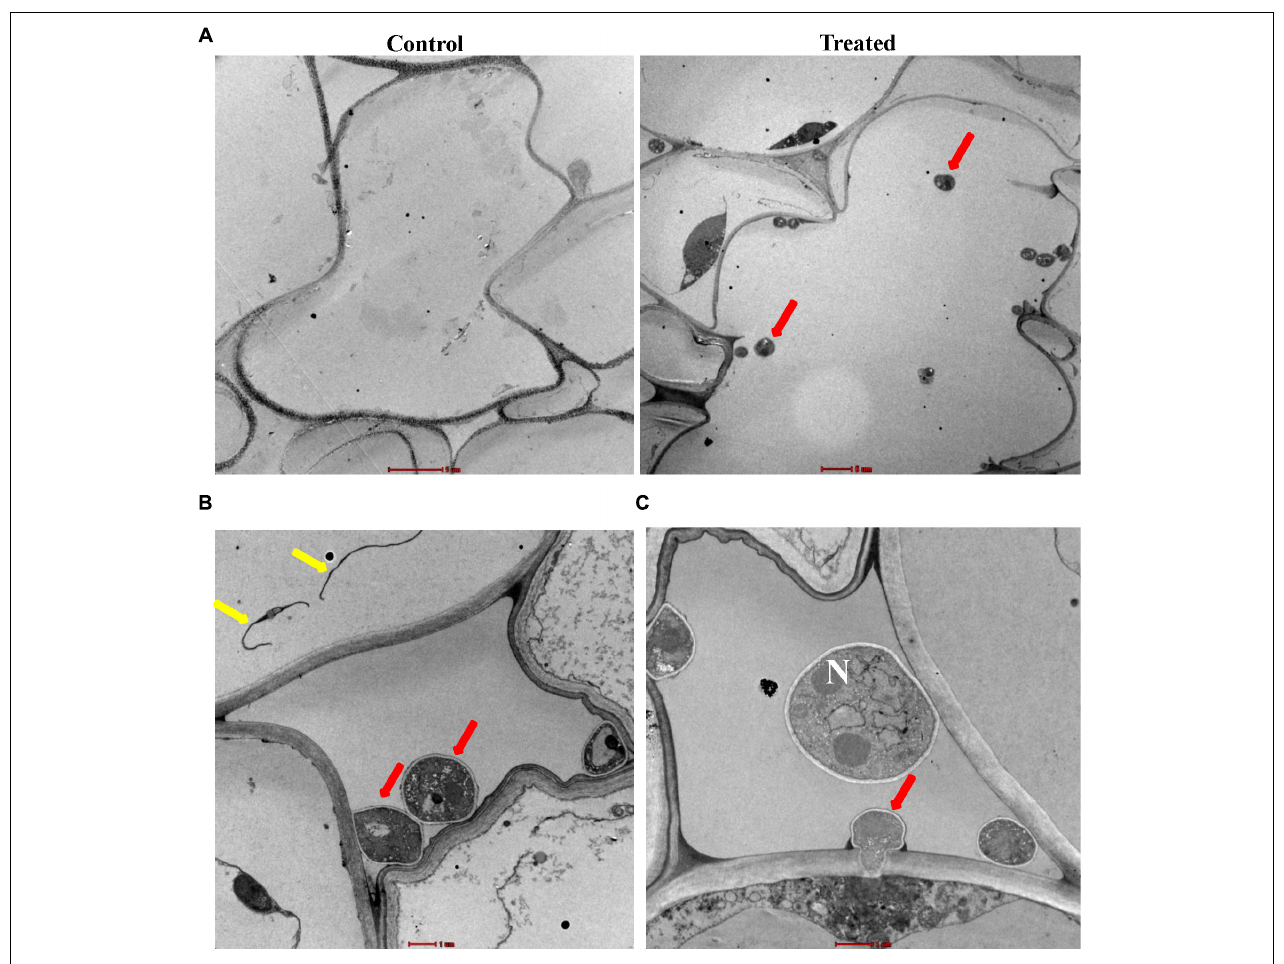
FIGURE 4 | Inter- and intra-cellular colonization of Salicornia bigelovii roots by Micromonospora chalcea UAE1. Transmission electron micrograph of ultra-thin sections of a 2-week-old S. bigelovii root of (A) non-inoculated (control; left, 2550 × ) and inoculated with M. chalcea UAE1 (treated; right; 1250 × ); (B) spores and substrate mycelium of M. chalcea UAE1 within the cortex (6000 × ); and (C) penetration of M. chalcea UAE1 of a neighboring root cortical cell (8200 × ). In (B,C) , all sections were stained with uranyl acetate and lead citrate showing the distribution of spores (red arrows) and substrate mycelium (yellow arrows). Bars: (A) 5 µ m; and (B,C) 1 µ m. N,